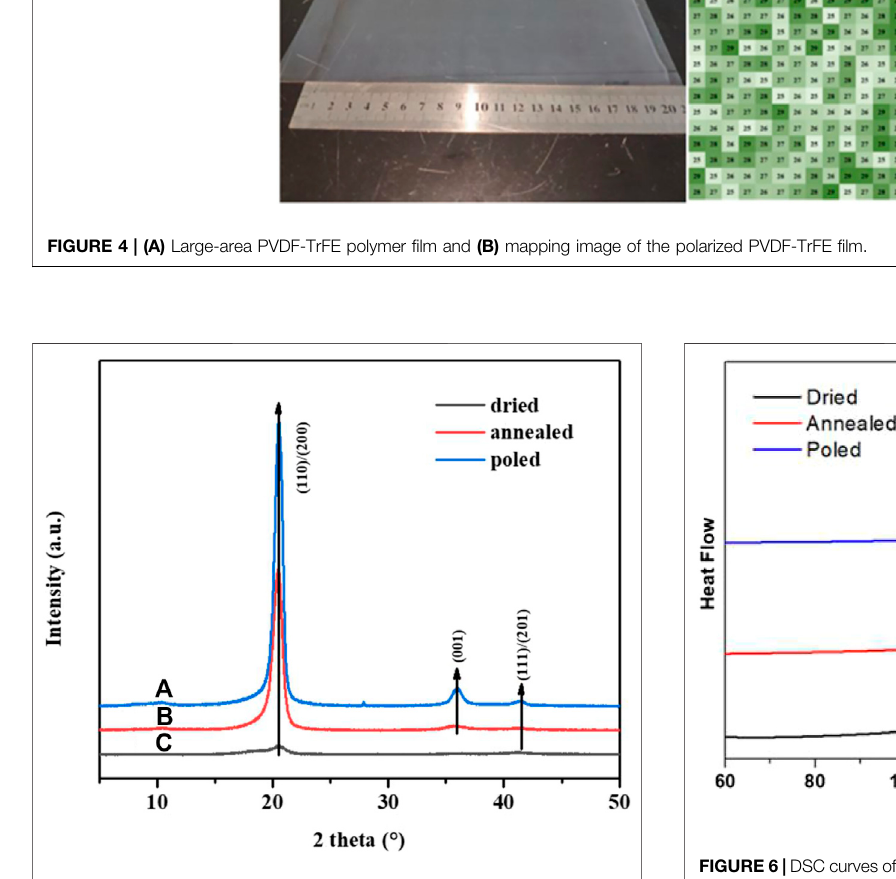
Frontiers in Energy Research |